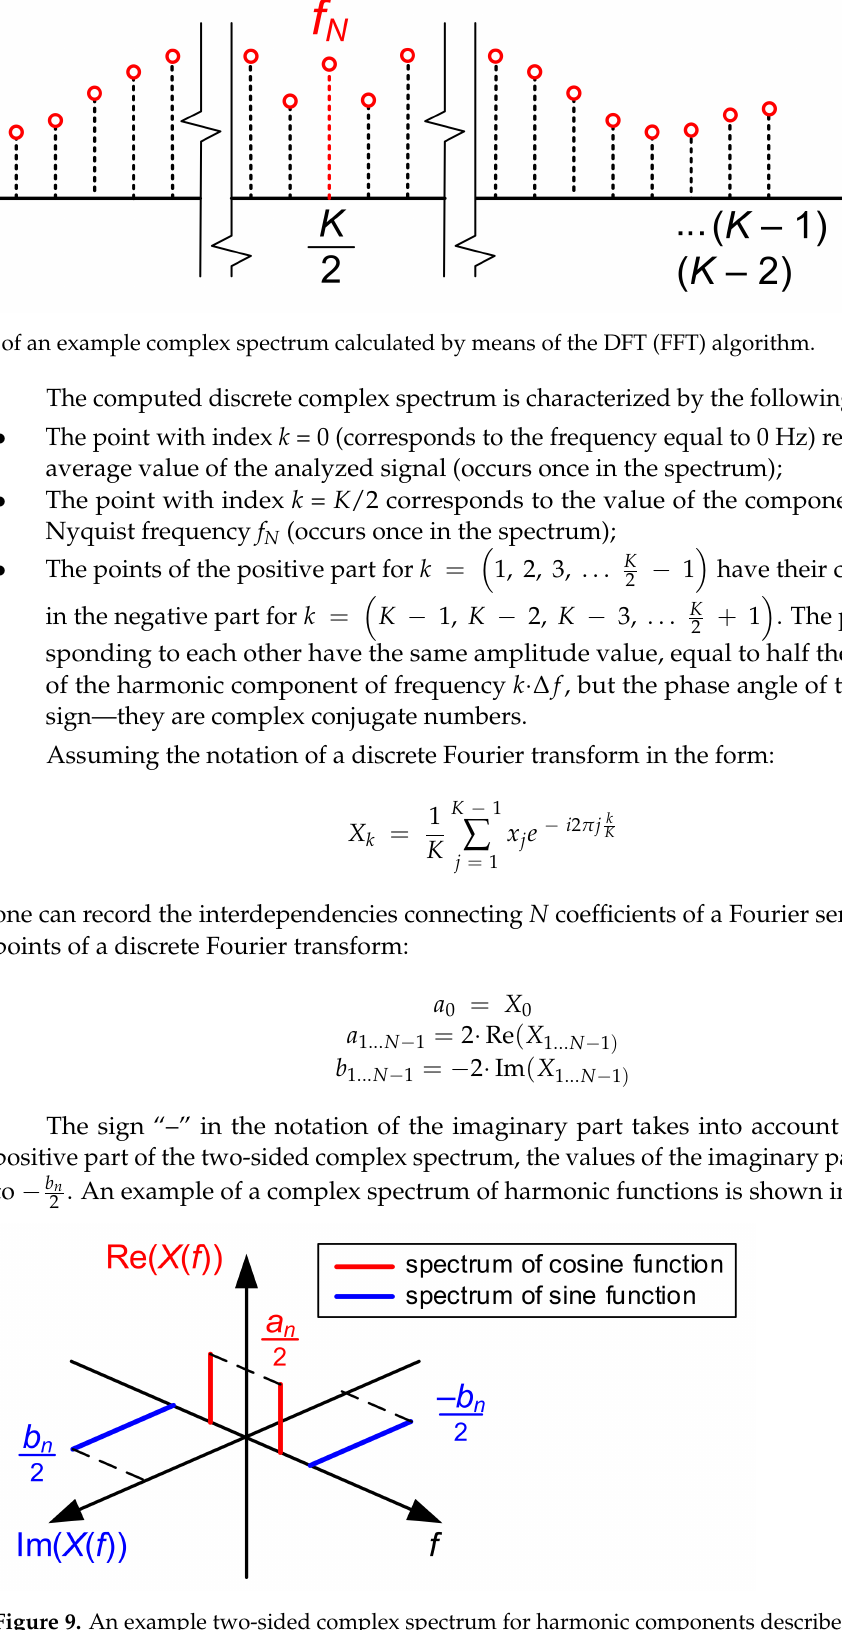
Figure 9. An example two-sided complex spectrum for harmonic components described by sine and cosine